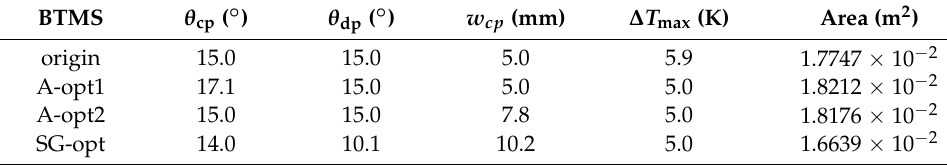
Table 3. Comparison before and after optimization at inlet airflow rate of 0.040 m 3